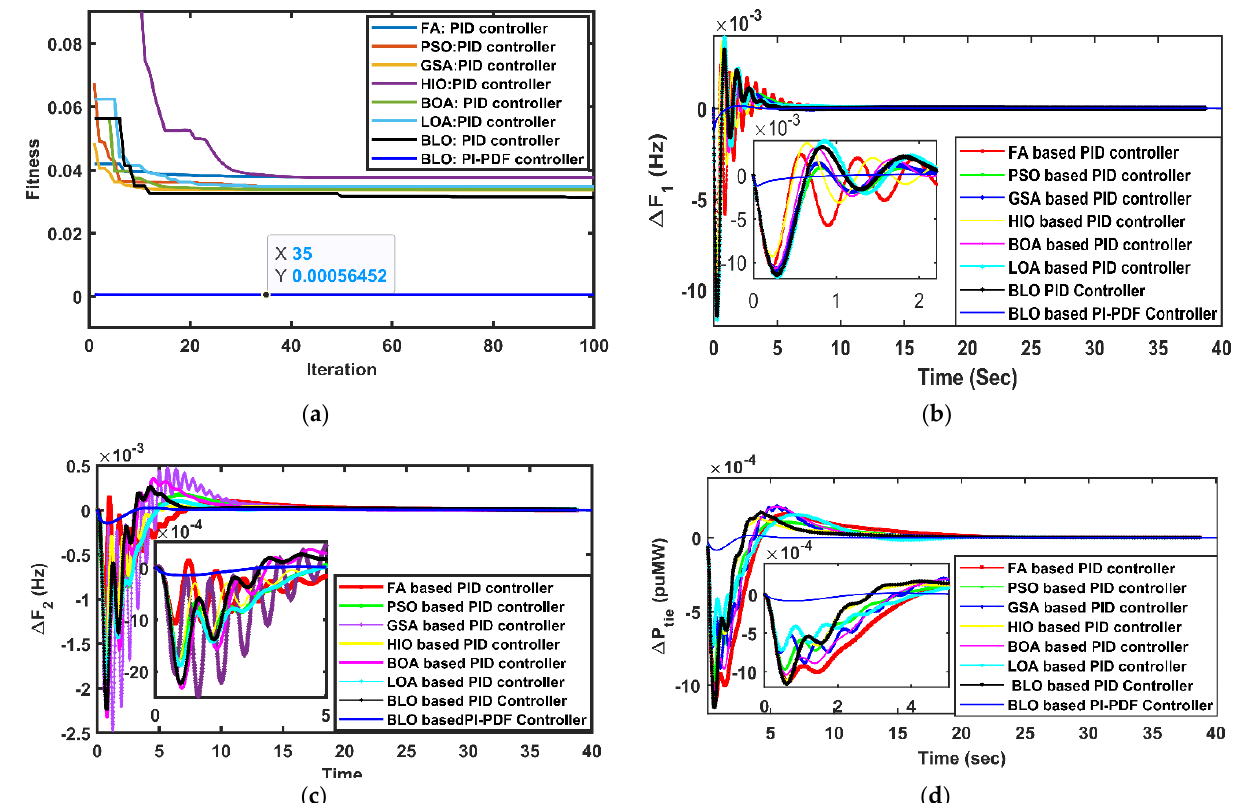
Figure 5. Dynamic response of power system for scenario-I: ( a ) Convergence characteristics, ( b ) Frequency response of area-1, ( c ) Frequency response of area-2, and ( d ) Tie-line power response.